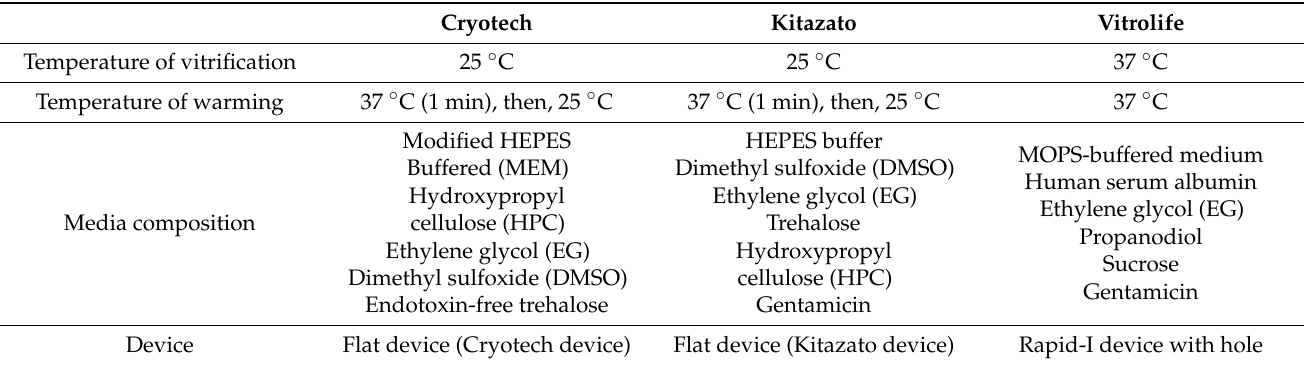
Table 1. The comparison of media composition and vitrification/thawing protocol between experi- mental groups (according to the manufacturers’ leaflets). Cryotech Kitazato Vitrolife Temperature of vitrification 25 ◦ C 25 ◦ C 37 ◦